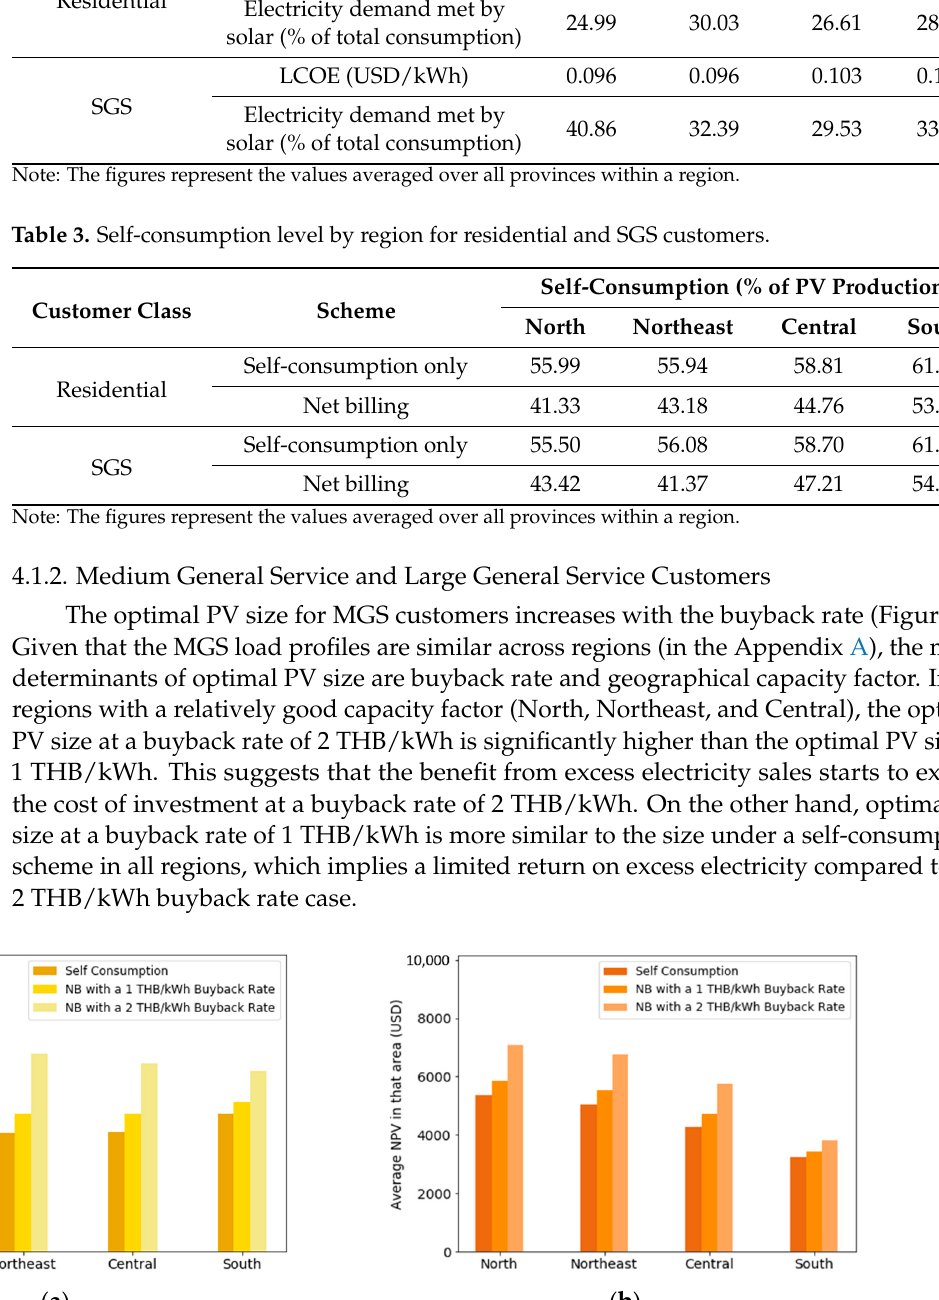
Table 3. Self-consumption level by region for residential and SGS customers.